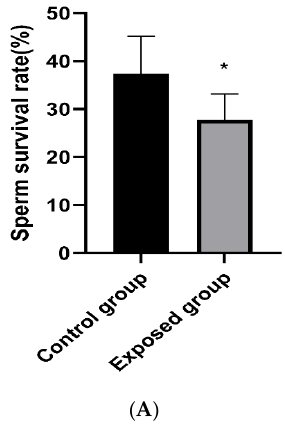
Figure 1. Body weight, food intake and organ coefficient of mice during the exposure period. ( A ) Body weight of mice; ( B ) Food intake of mice. The data are expressed as the mean ± SD (n = 8) and analyzed by dependent sample t -test.